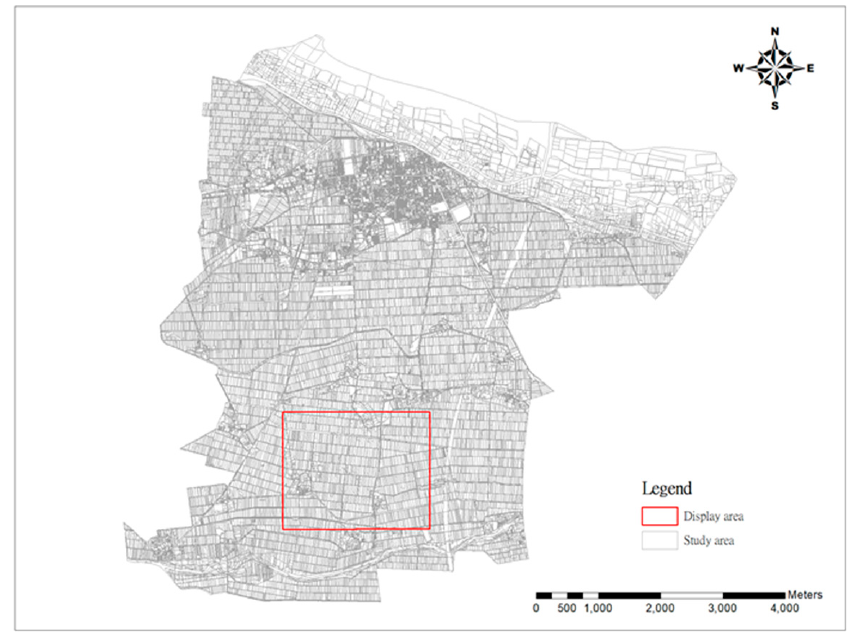
Figure 7. Display area with detailed